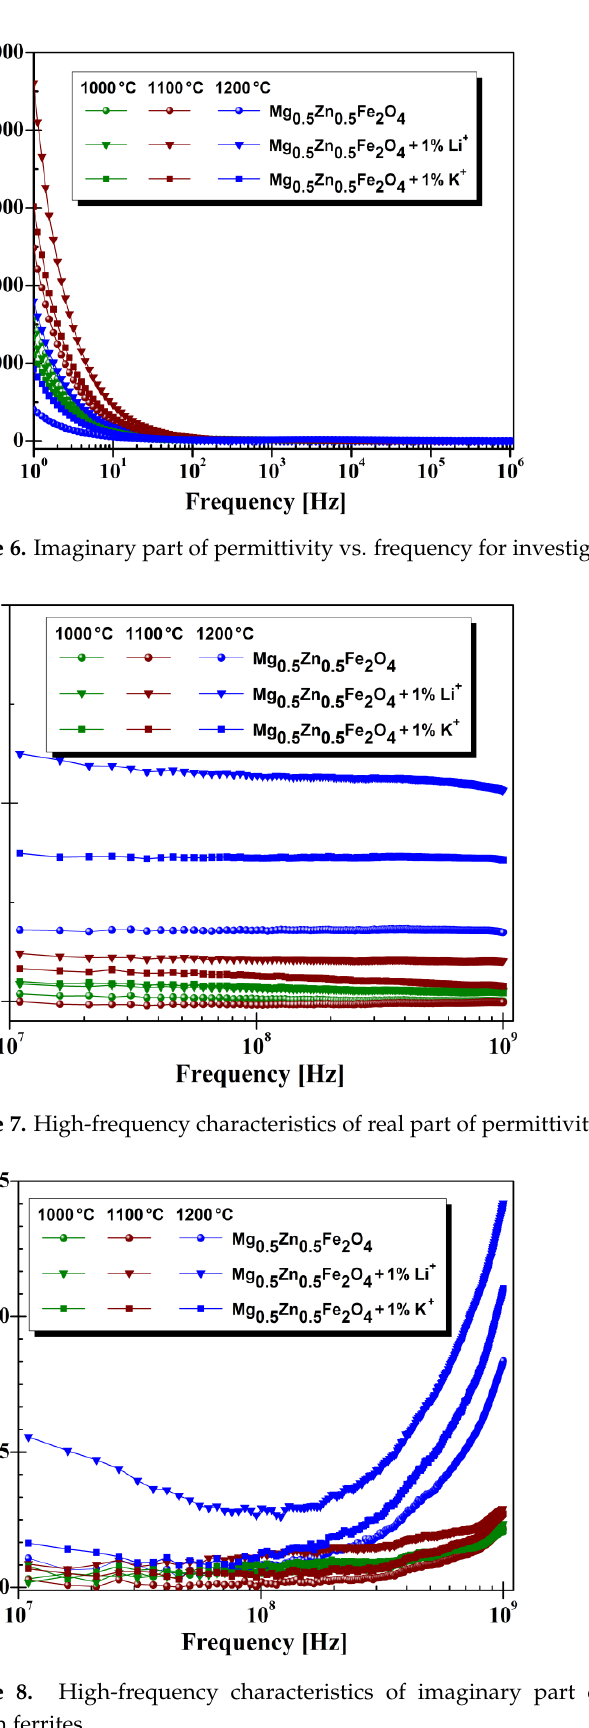
Figure 8. High-frequency characteristics of imaginary part of permittivity for investigated Mg-Zn